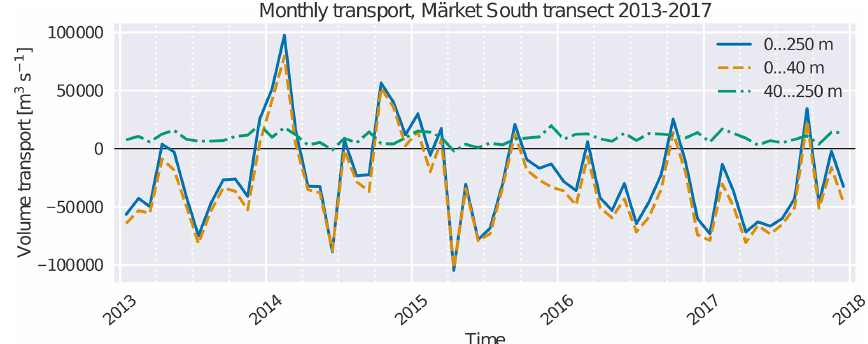
Figure 10. Time series of modelled monthly mean volume transports through the Märket south transect near the northern edge of the Åland Sea 2013–2017. Positive values indicate northward transport. Values for the whole water column, the upper water column up to 40m and the lower water column below 40m are